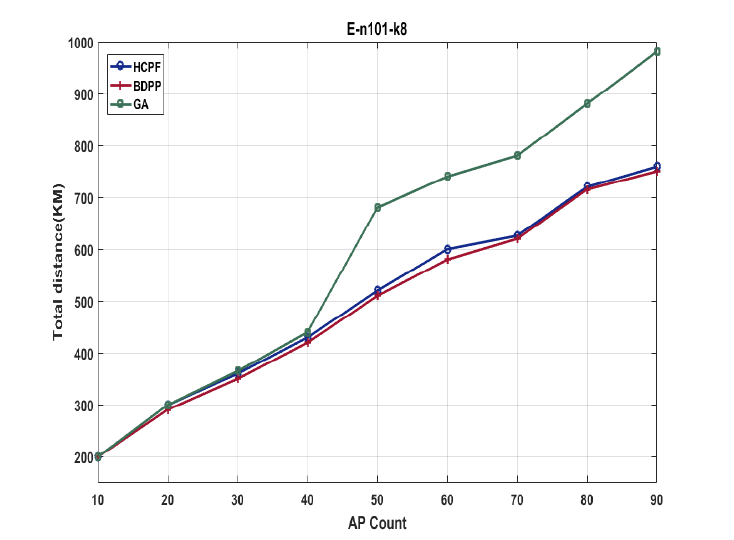
Figure 13. AP count vs. total